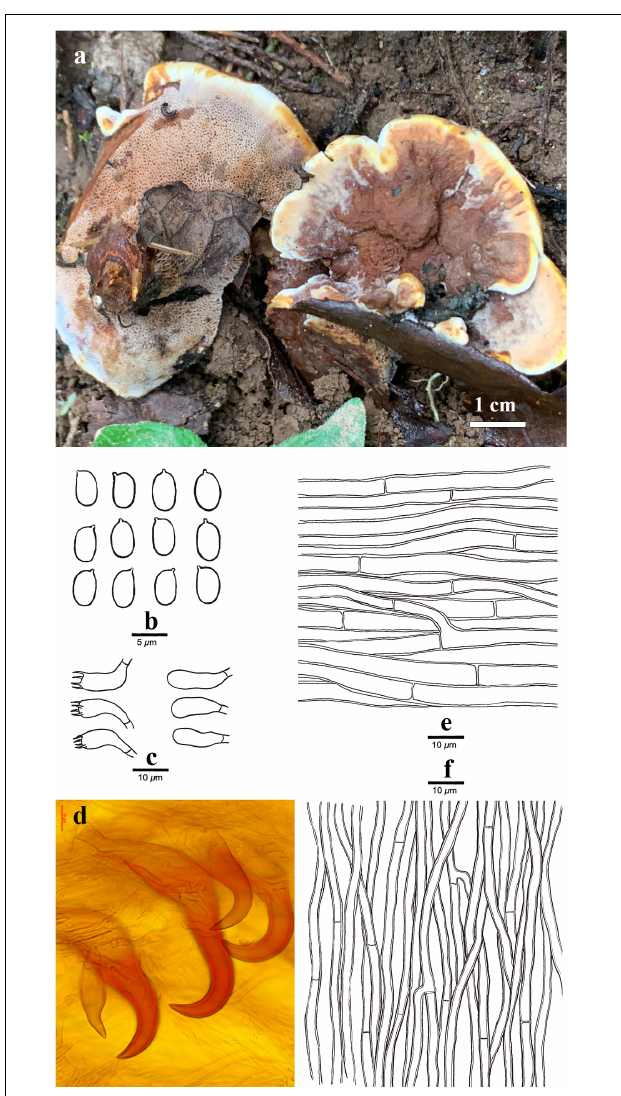
FIGURE 5 | Basidiocarps and microscopic structures of Onnia himalayana (Holotype, Dai 22620). (a) Basidiocarps of Onnia himalayana ; (b) Basidiospores; (c) Basidia and basidioles; (d) Hymenial setae; (e) Hyphae from upper tomentum; and (f) Hyphae from